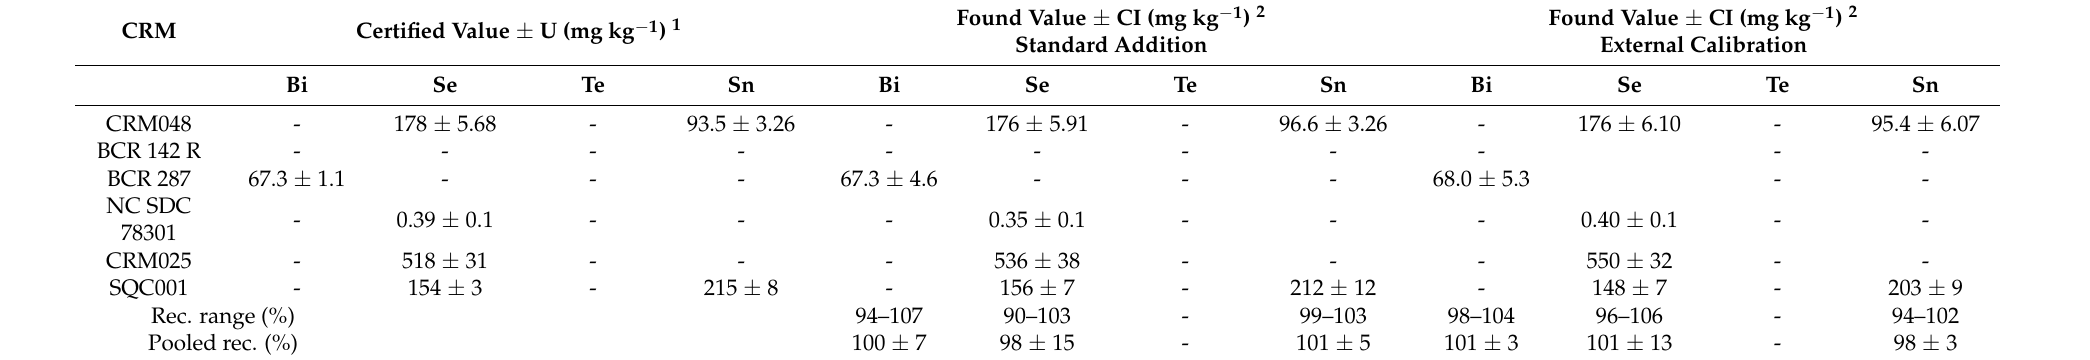
Table 5. Results for the analysis of soil and water sediment CRMs by SSETV- µ CCP-OES method using Maya2000 Pro microspectrometer for Bi, Se, Te, and Sn and standard addition and external